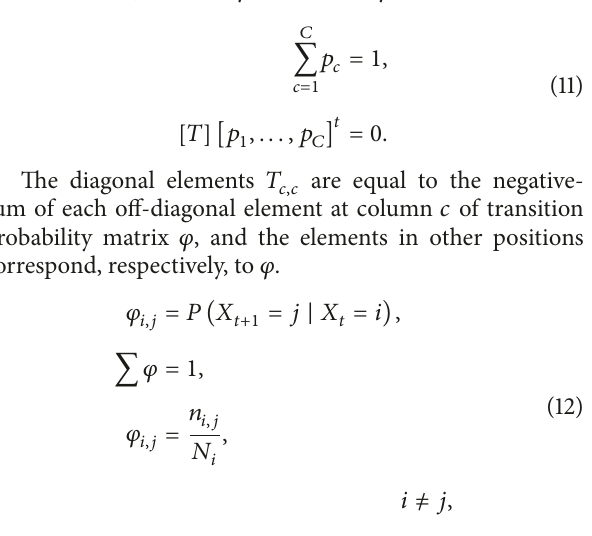
different states are given with 𝜆 and 𝜇 ,